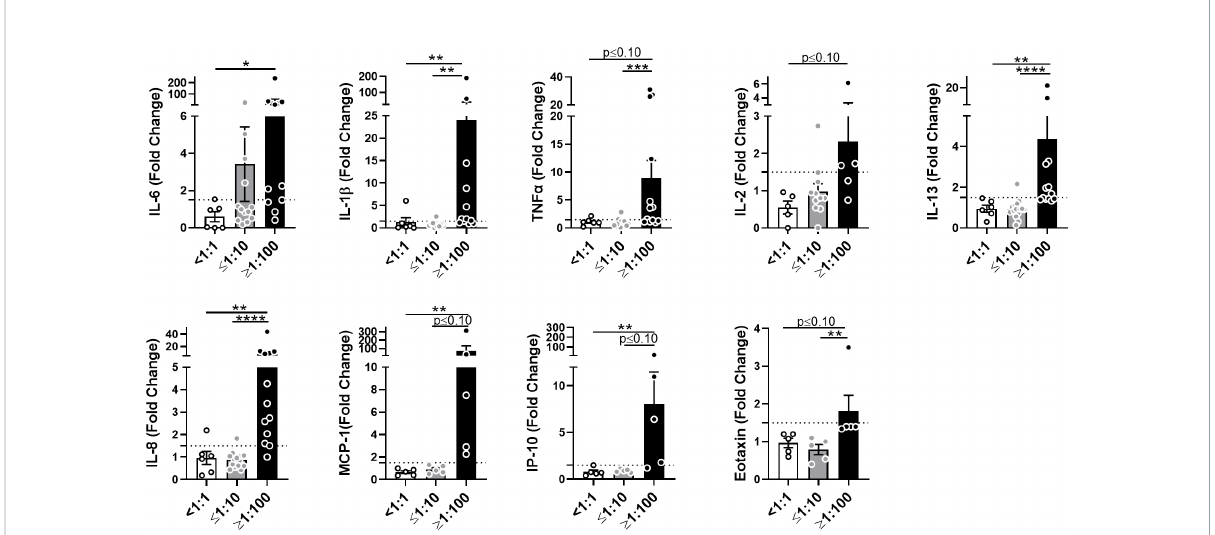
FIGURE 4 AAV NAbs enhance anti-AAV pro-in fl ammatory cytokine response in blood. Cytokine and chemokine secretion from whole blood stimulated with 5×10 11 vg/mL of AAV-Spark100 for 24 hours. Samples were categorized based on their titers of anti-AAV-Spark100 neutralizing antibodies as indicated under x axis. Bars represent mean fold-change ± SEM of each analyte ’ s concentration measured in AAV-stimulated relative to unstimulated blood. Symbols represent the values of each donor. Dashed lines signify a 1.5-fold positivity cutoff. Signi fi cance was determined by the Kruskal-Wallis test with Dunn ’ s multiple comparisons test. *p ≤ 0.05; **p ≤ 0.01; ***p ≤ 0.001; ****p ≤